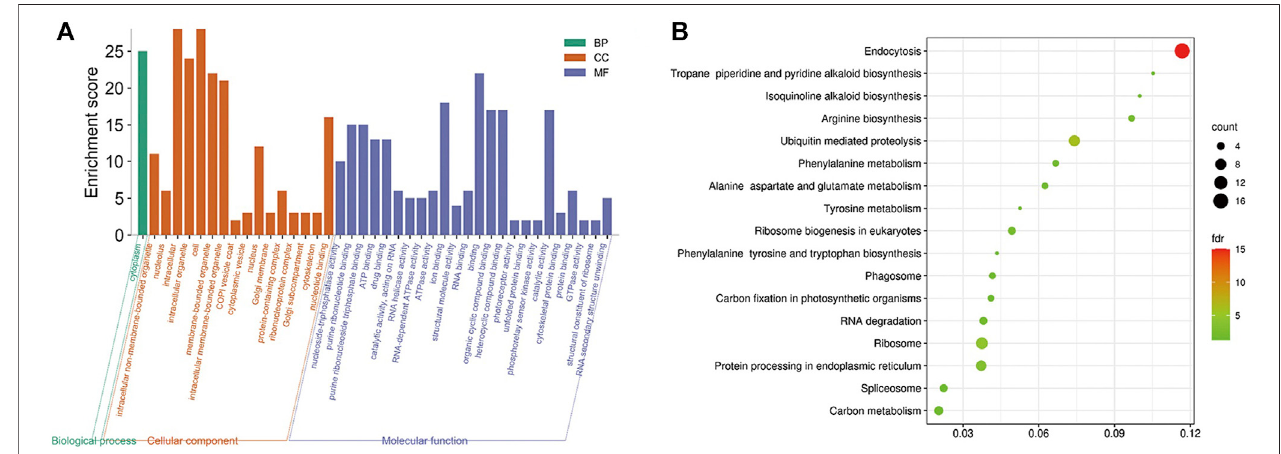
FIGURE 8 | (A) Five modules signi fi cantly enriched GO functional enrichment module diagram and (B) KEGG enrichment pathway bubble diagram of